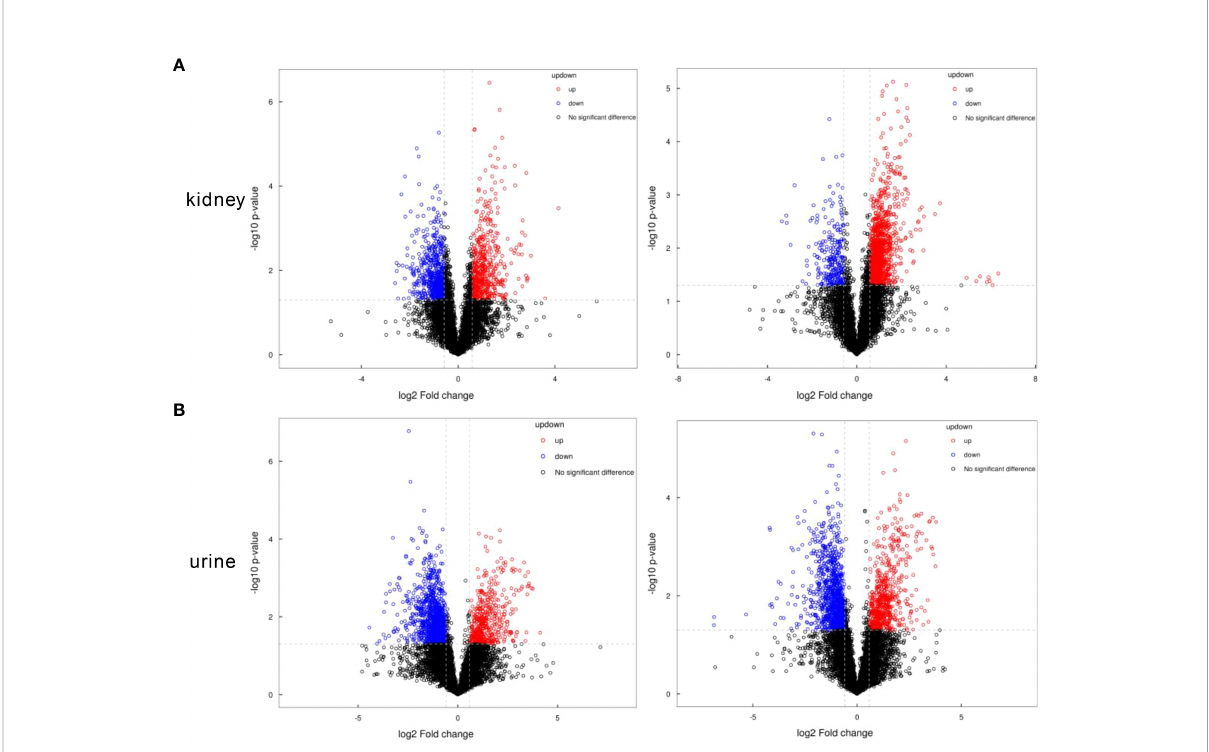
FIGURE 3 The volcanograms of the metabolic pro fi les in the kidney and urine samples. (A) Differential metabolites of the kidney samples under the negative or positive modes. (B) Differential metabolites of the urine samples under the negative or positive modes. Red represents the higher level and blue represents the lower